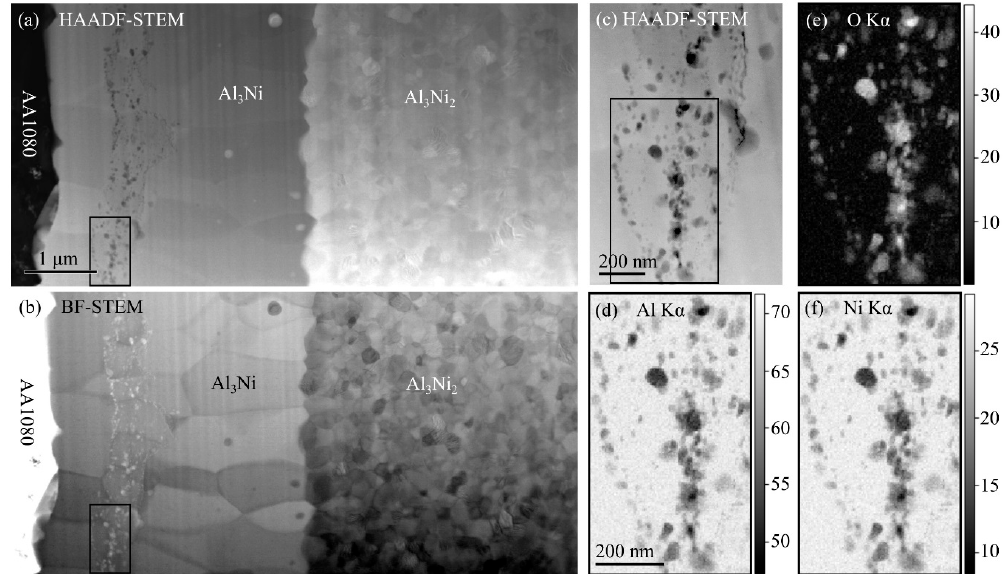
Figure 7. ( a ) HAADF-STEM and ( b ) corresponding BF-STEM image of the interface after post-rolling heat treatment at 550 °C for one hour. Elongated Al 3 Ni and equiaxed Al 3 Ni 2 grains can be seen, in addition to fine particles inside the Al 3 Ni layer that compose a line that runs approximately parallel to the interface. ( c ) HAADF-STEM image showing an enlargement of a part of the line of fine particles. ( d ) Al K α , ( e ) O K α and ( f ) Ni K α denoised EDS maps from the region marked by black squares in ( a ), ( b ) and ( c ), showing the relative composition in at%. Note the differences in the compositional range for each element, as shown by the color bars to the right of each EDS map.